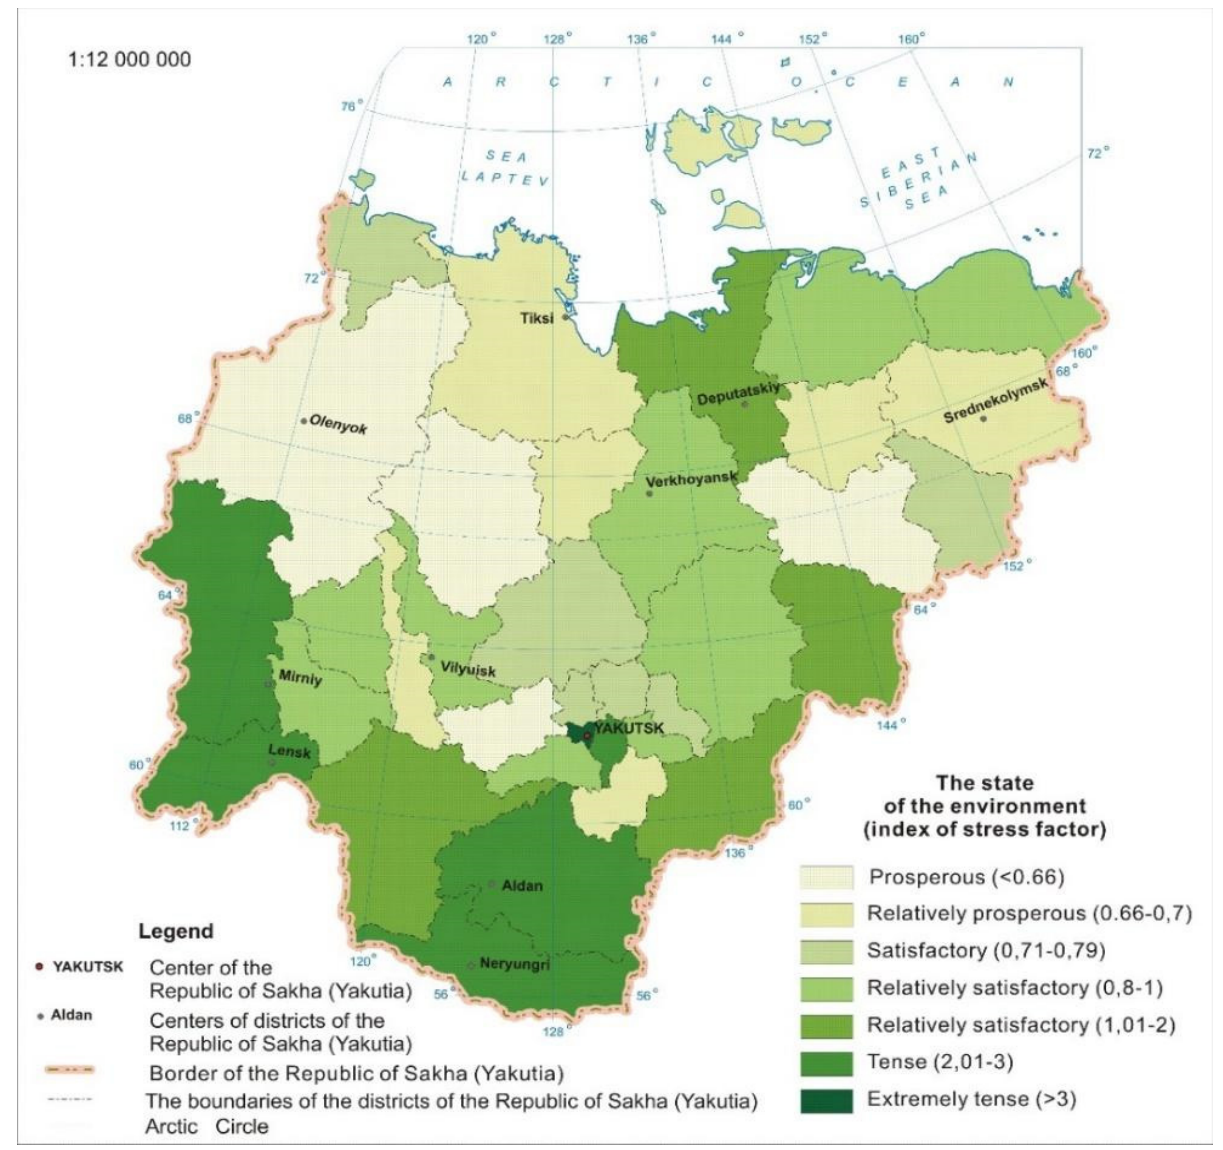
Figure 2. Comprehensive ecological and economic assessment of Yakutia’s environmental state.